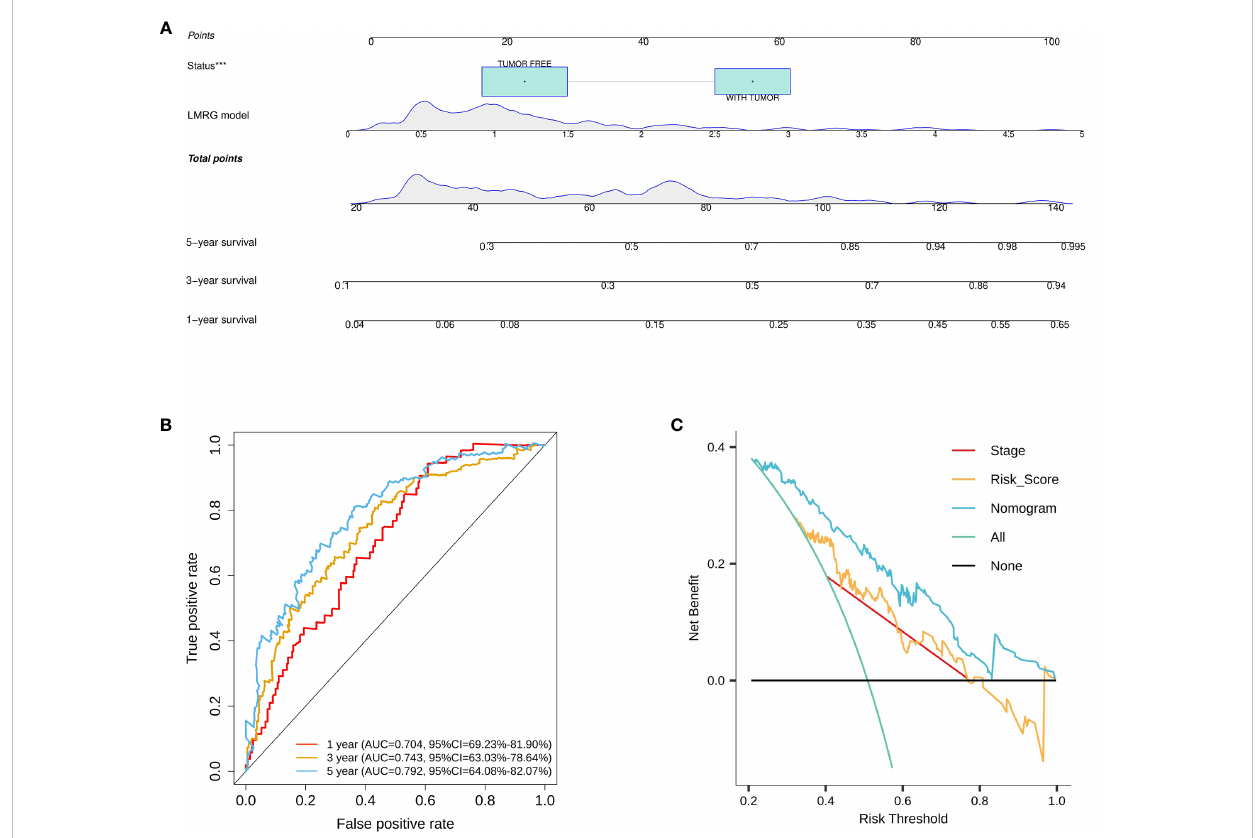
FIGURE 5 Construction and validation of a nomogram for HCC. (A) A nomogram was constructed based on cancer status and six LMRGs. (B) ROC curves of the nomogram in the training cohort. (C) Decision curve analysis of the nomogram in the TCGA cohort at 5 years.